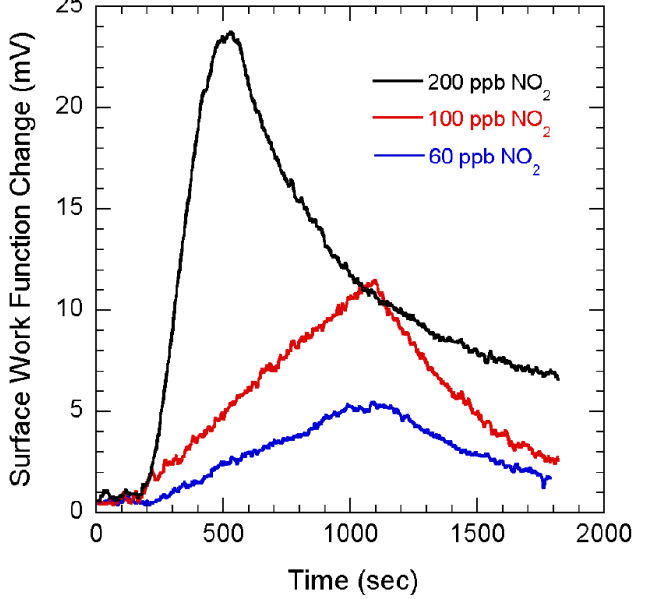
Figure 6: Surface work function changes of NG layers with flow of 200, 100 and 60 ppb NO